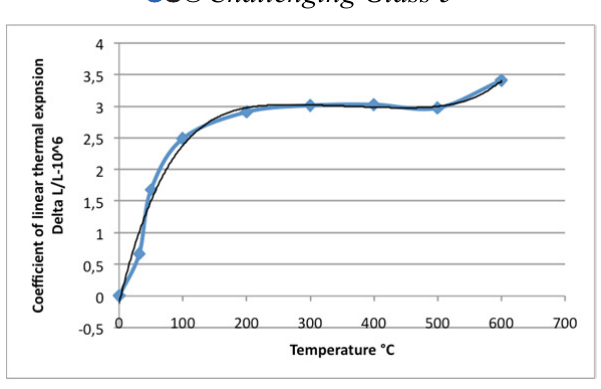
Fig. 4 Coefficient of linear thermal expansion over a temperature range up to